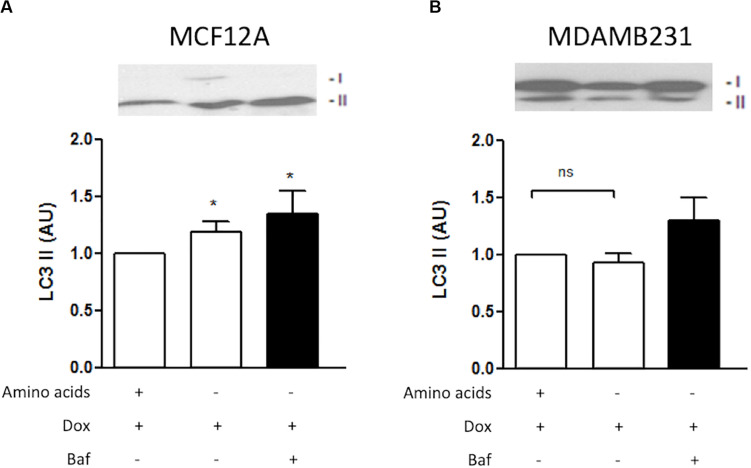
LC3 II protein levels during amino acid starvation in MCF12A and MDAMB231 cells. Representative western blots and Bar graphs showing densitometric representations of LC3 II protein levels in MCF12A (A) and MDAMB231 (B) cells. Each value represents the mean ± SEM of at least three independent determinations. AU, arbitrary units; *p < 0.05 vs. amino acid control; ns, no significance.